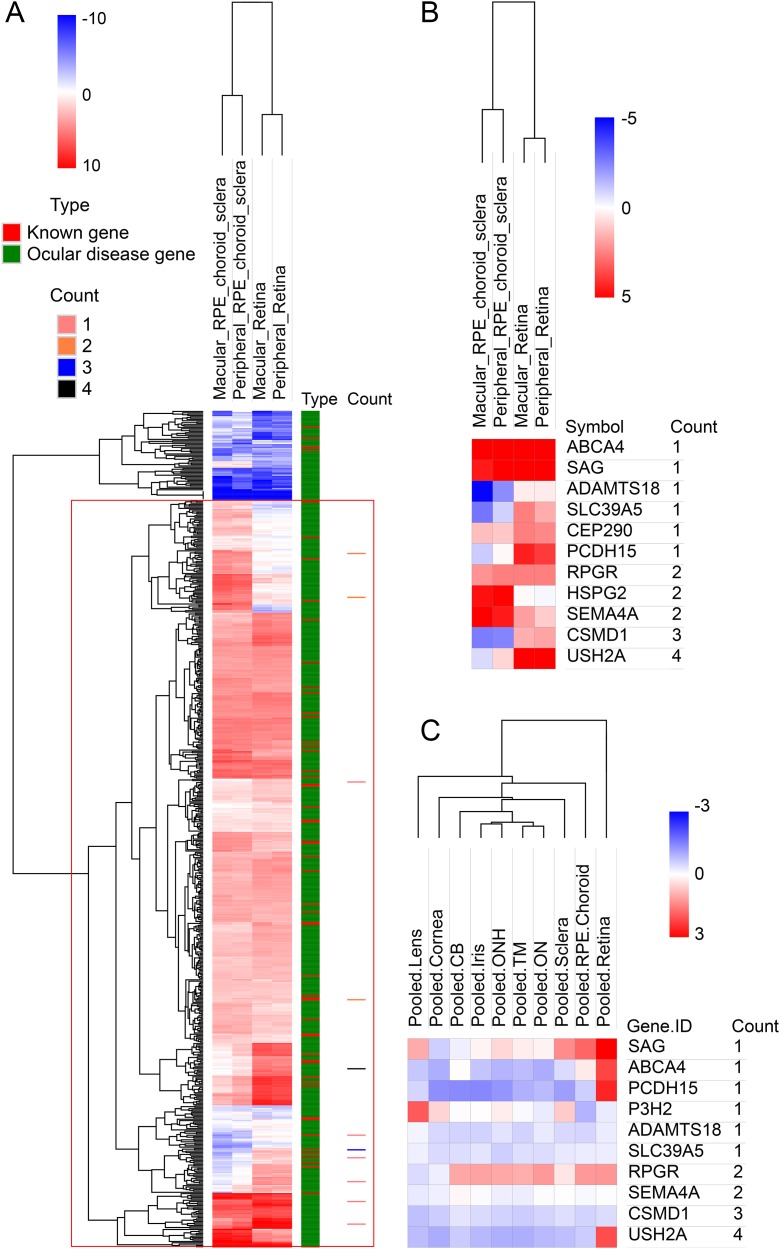
Hierarchical cluster analysis of gene expression.(A) The heatmap of 709 known genes associated with eye diseases in RNA-seq expression profile. The 709 genes were divided into known high myopia genes and ocular disease genes, as shown in different colors in type column. Count column represents the sample count of pathogenic variants for our candidate genes. (B) The heatmap of candidate genes in RNA-seq expression profile. (C) The heatmap of candidate genes in microarray expression profile.